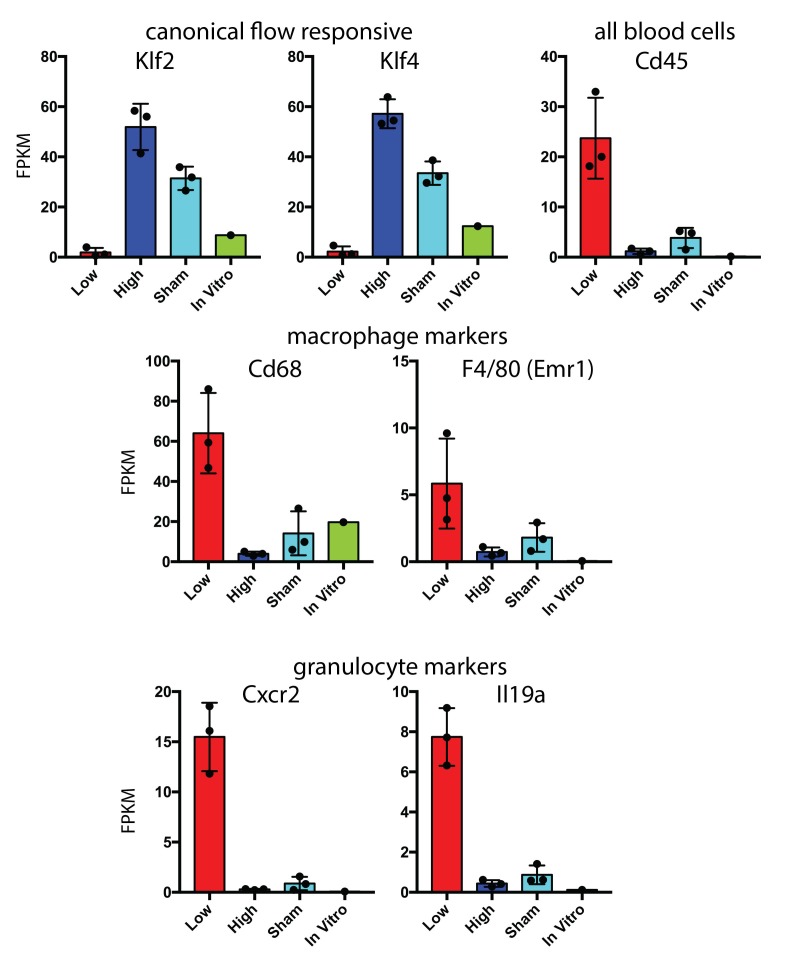
Hematopoietic cell recruitment within 48 hr of low and disturbed flow.Comparison of RNA-seq data from carotid intima 48 hr after the induction of low and disturbed flow. Canonical flow-responsive genes (Klf2 and Klf4) and markers of recruited immune cells (CD45, Cd68, F4/80, Cxcr2 and Il19a) are shown. Each point represents pooled RNA from multiple intimal preparations. In vitro is a single isolated and sorted cell line from aortic endothelium based on eGFP expression (Cdh5(PAC)-CreERT2; mTmG).